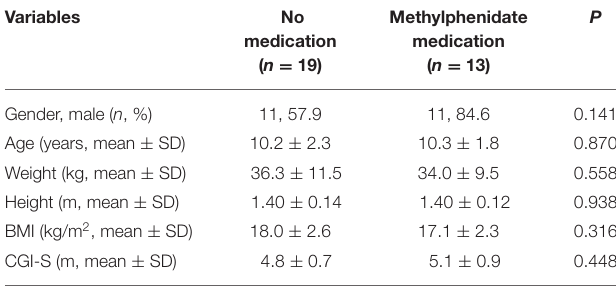
TABLE 2 | Characteristics according to use of methylphenidate medication.